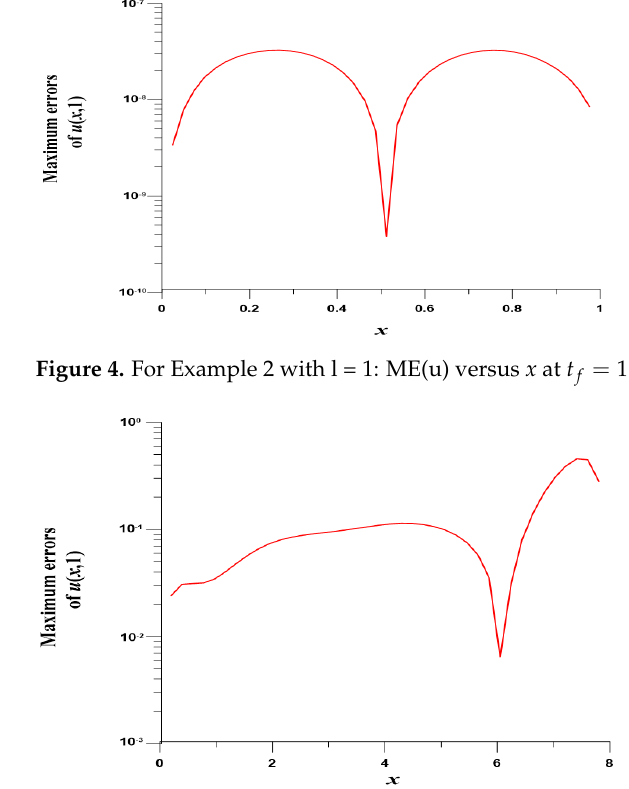
Figure 5. For Example 2 with l = 8: ME( u ) versus x at t f =